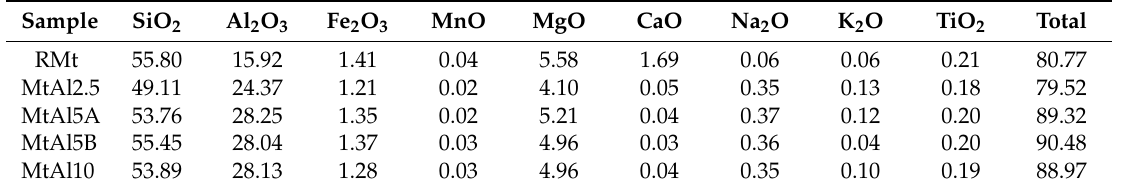
Table 2. Chemical composition of the solids, expressed in content of their metallic oxides (mass percentage).